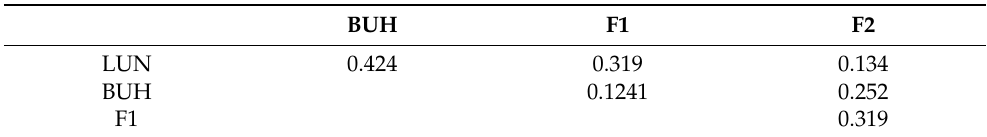
Table 3. Pairwise F ST values (upper diagonal) of the four dog groups: Lundehund (LUN), Buhund (BUH), first-generation crosses LUN × BUH (F1) and first-generation backcrosses F1 × LUN (F2). All F ST comparisons were highly statistically significant ( p < 0.001).